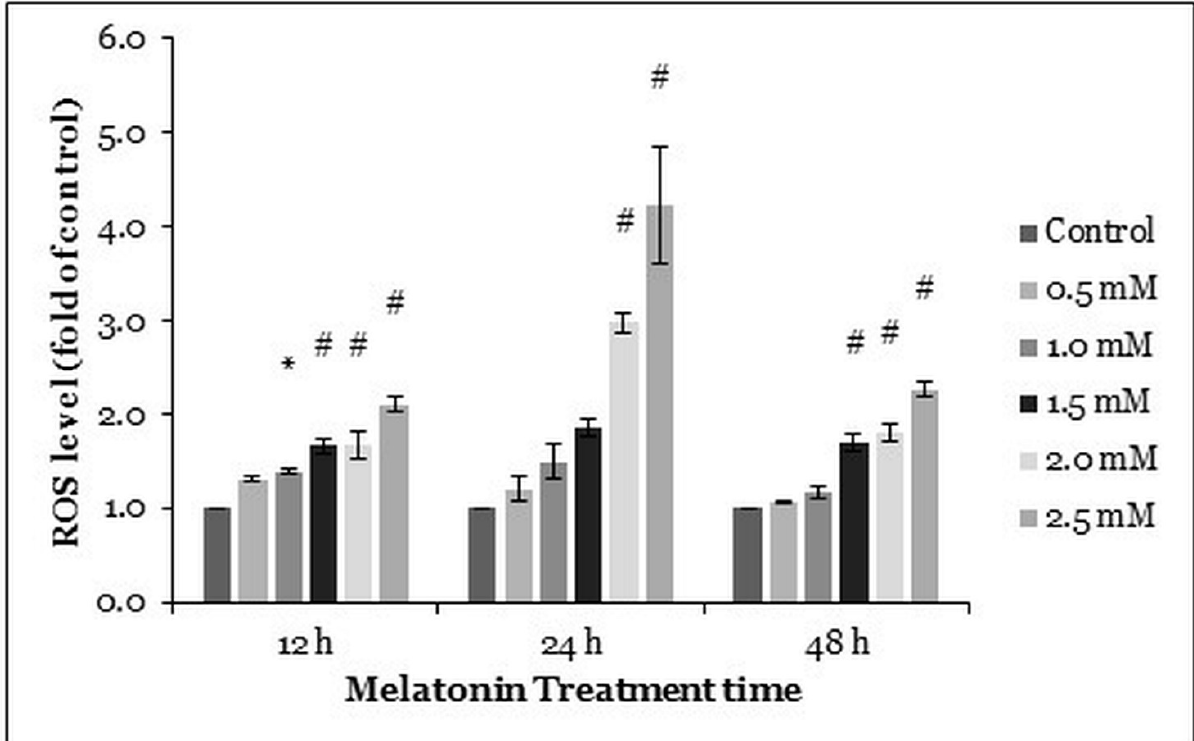
Figure 2. ROS generation in HT-29 cells after treated with various concentrations of melatonin for 72 h. The ROS generation was measured by DCFH-DA staining. Each bar represents mean ± SEM of three independent experiments. One-way ANOVA, followed by Dunnett’s post hoc test, was performed to compare each treatment group with the control. Statistically significantly different from the control: *, p < 0.05; #, p < 0.01.